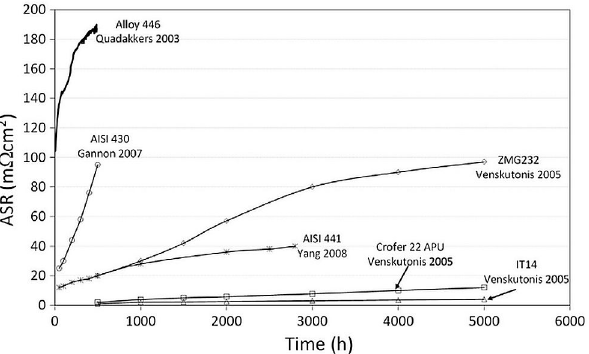
Figure 8. Area-Specific Resistance (ASR) evolution of typical interconnect materials over exposure time [6].